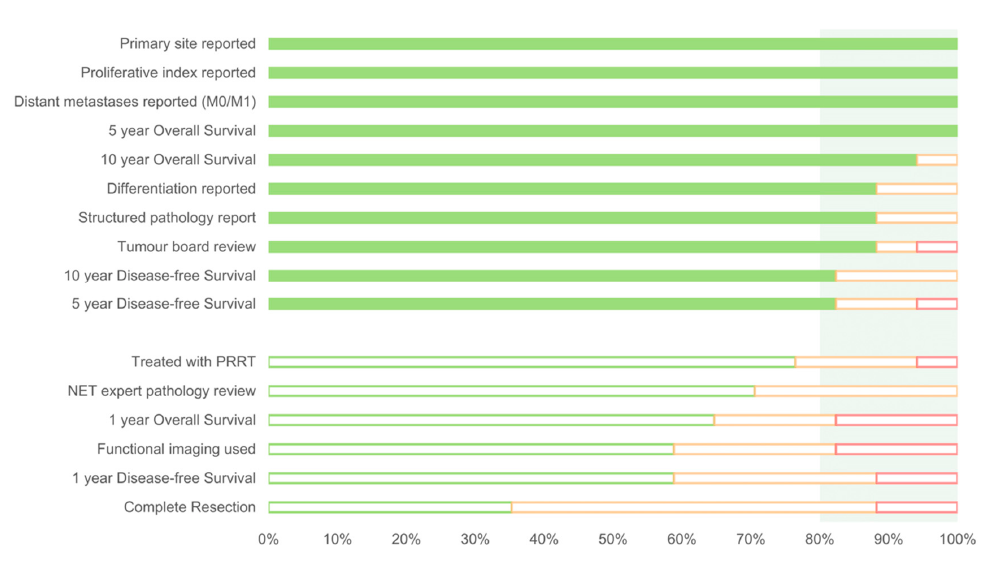
Figure 3. The expert group rated the final Round 2 indicators as appropriate (green), uncertain (orange) or inappropriate (red). The light green shaded area highlights those indicators rated appropriate by more than 80% of the group, thus achieving consensus. Table 2. Final consensus-derived NET QPIs.